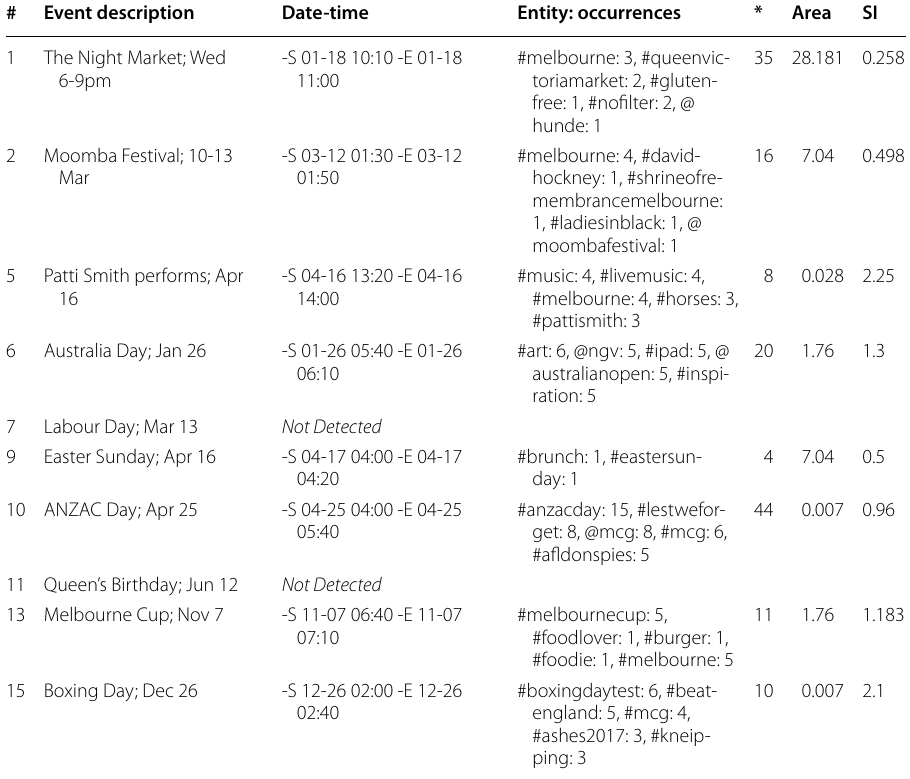
Table 8 Recall results: Melbourne common events occurred in 2017